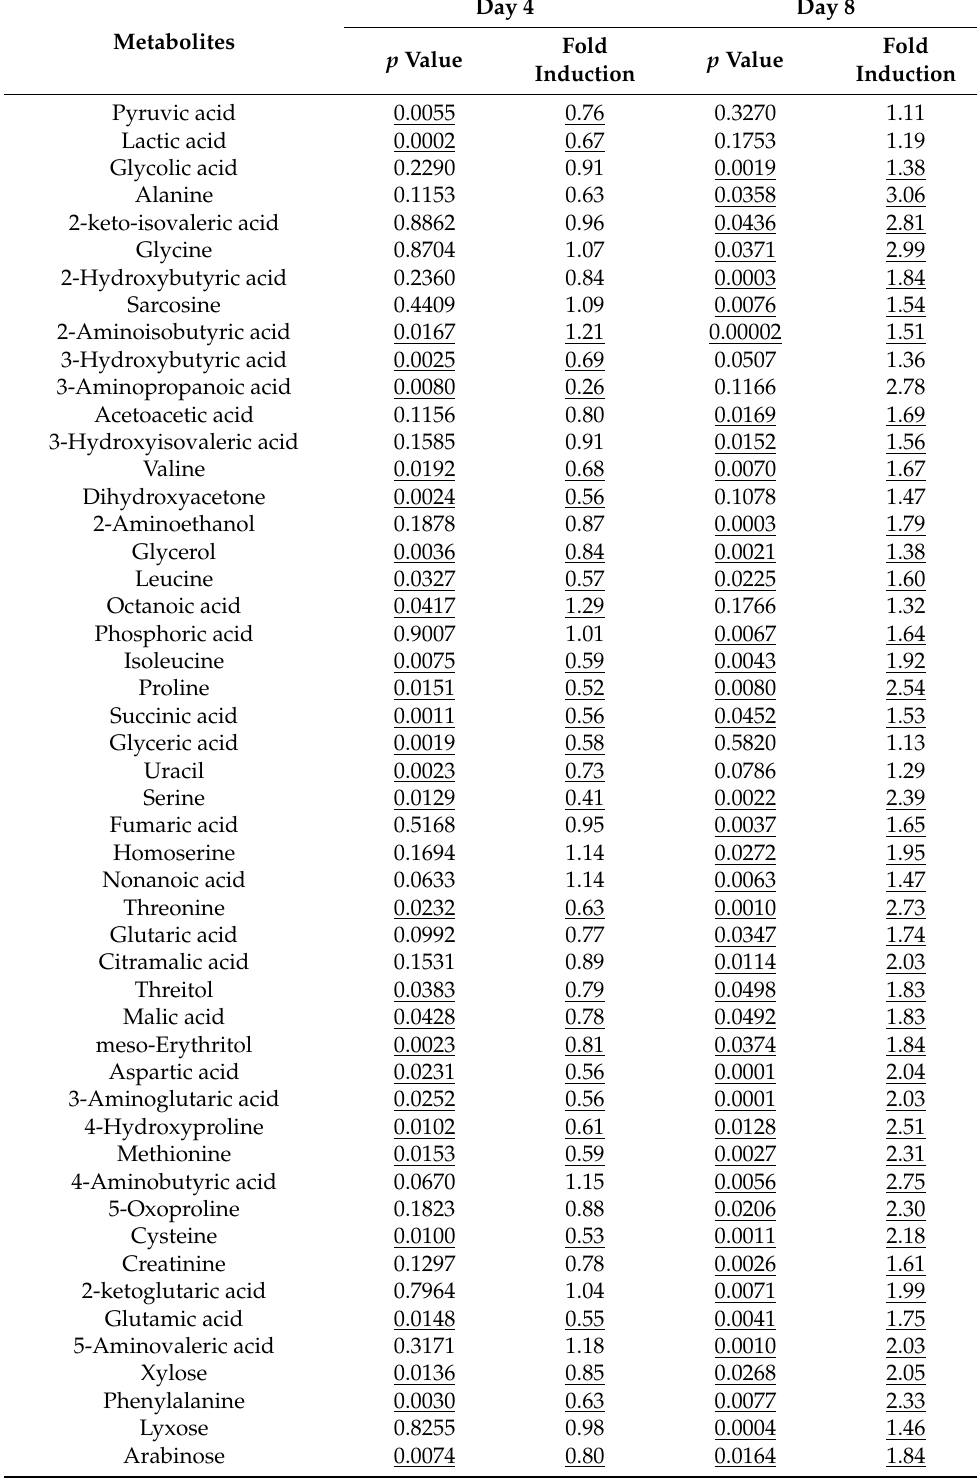
Table 2. The list of significantly changed metabolites in adipocytes for 4 and 8 days after differentia- tion. Values are represented as the fold-induction of peak intensity of adipocytes treated by ISLCs and control for 4 and 8 days after differentiation (n = 4). p values were calculated according to the Student’s t -test, andunderlines indicate p values lower than